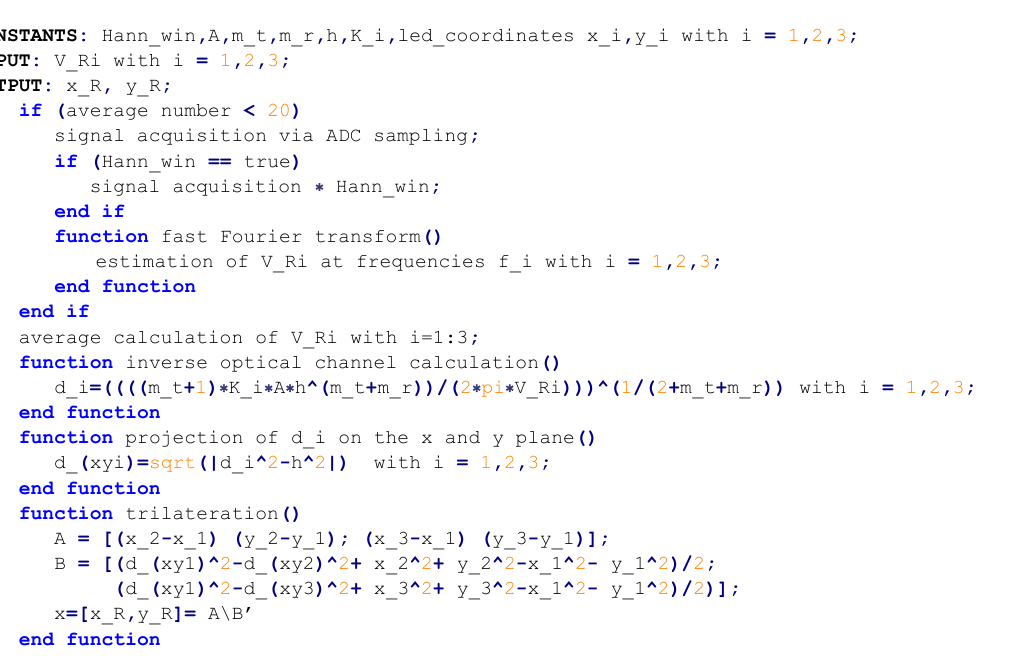
Figure 3. Architecture of the proposed positioning system: the transmitter (i.e., LED driver driven by three waveform generators, three LEDs), the receiver (i.e., the PV module with its conditioning circuit, the battery management system and the demodulating system—MCU and LoRa transceiver), the backend side (i.e., the LoRa gateway forwarding the transmitted packets to the server).